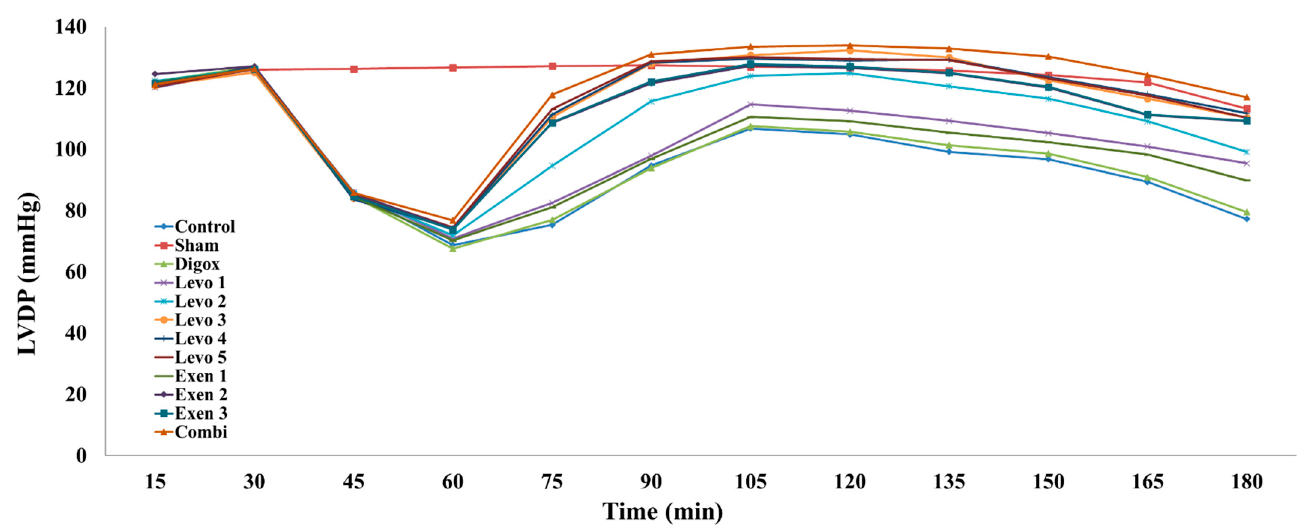
Figure 5. Changes in LVDP across groups over